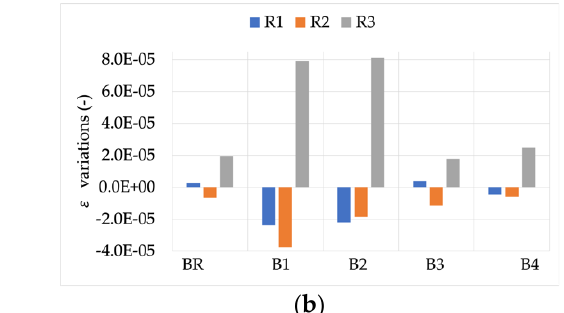
Figure 5. THD variations, compared to the reference values, vs. burden. ( a ) RCs ’ measuring signal Y with THD 4.8%; ( b ) RCs ’ measuring signal Z with THD 9.2%.